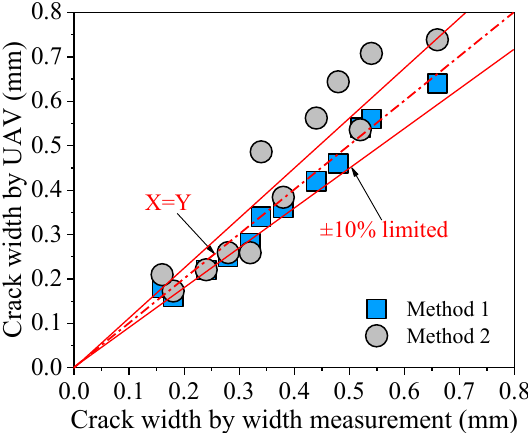
Figure 13. Comparison of crack width values by the UAV and width measurements.